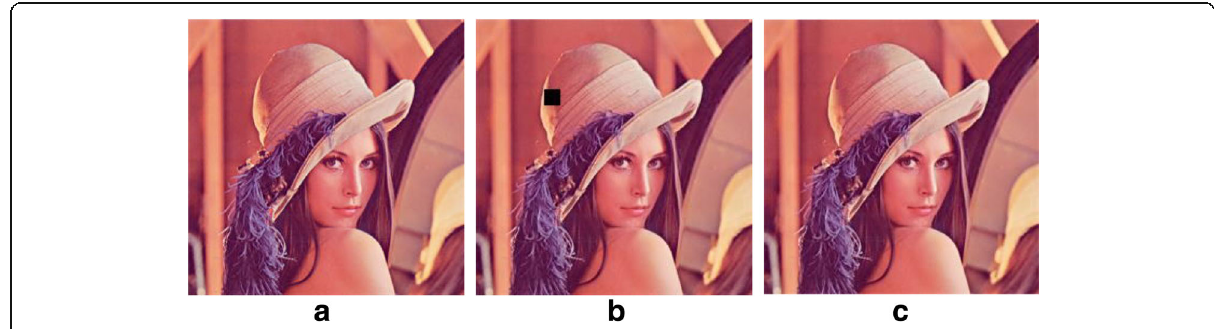
Fig. 5 Fitting a missing region using MLS. a Original image. b Mask. c The fitted